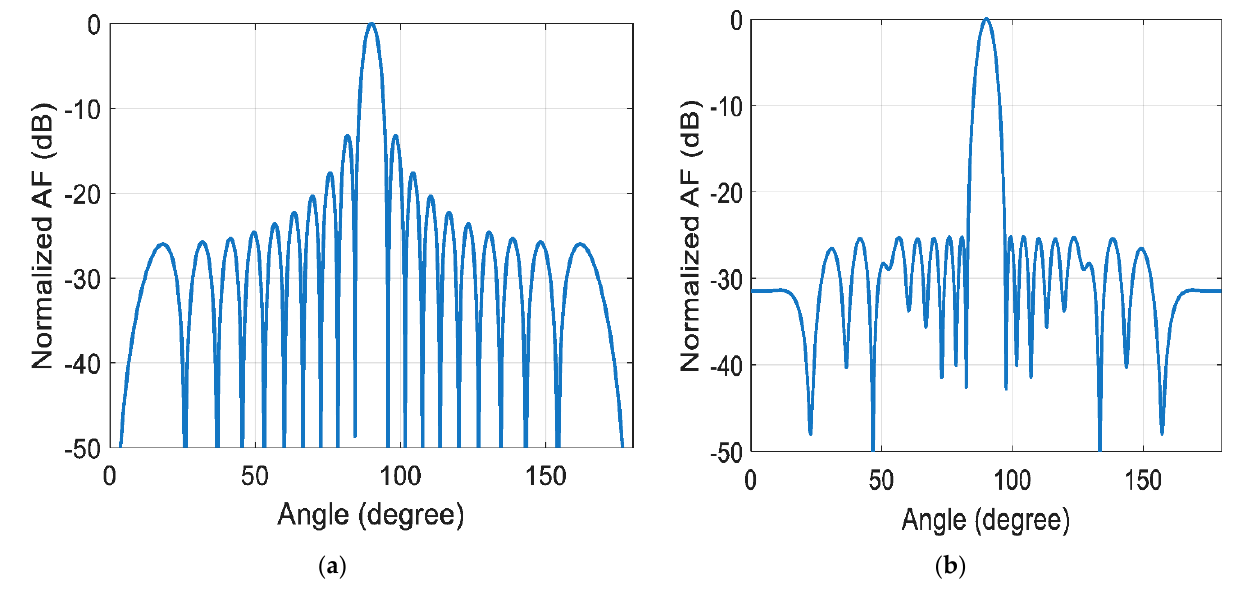
Figure 4. The normalized array factor for 2- element array antenna (a) using uniform distribution and (b) using FKE opti- Figure 3. The normalized array factor for 2- element array antenna ( a ) using uniform distribution and ( b ) using FKE optimization. mization.